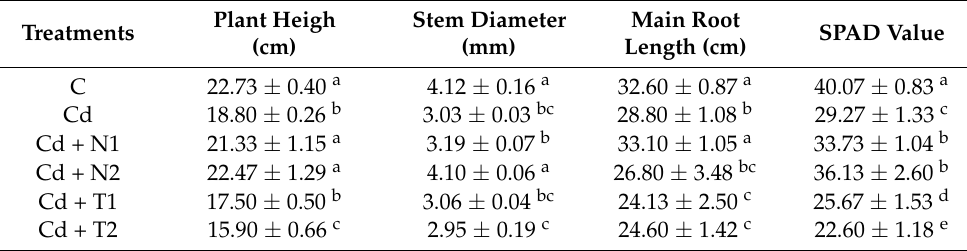
Table 1. Growth indices of tomato plants under Cd stress. Treatments